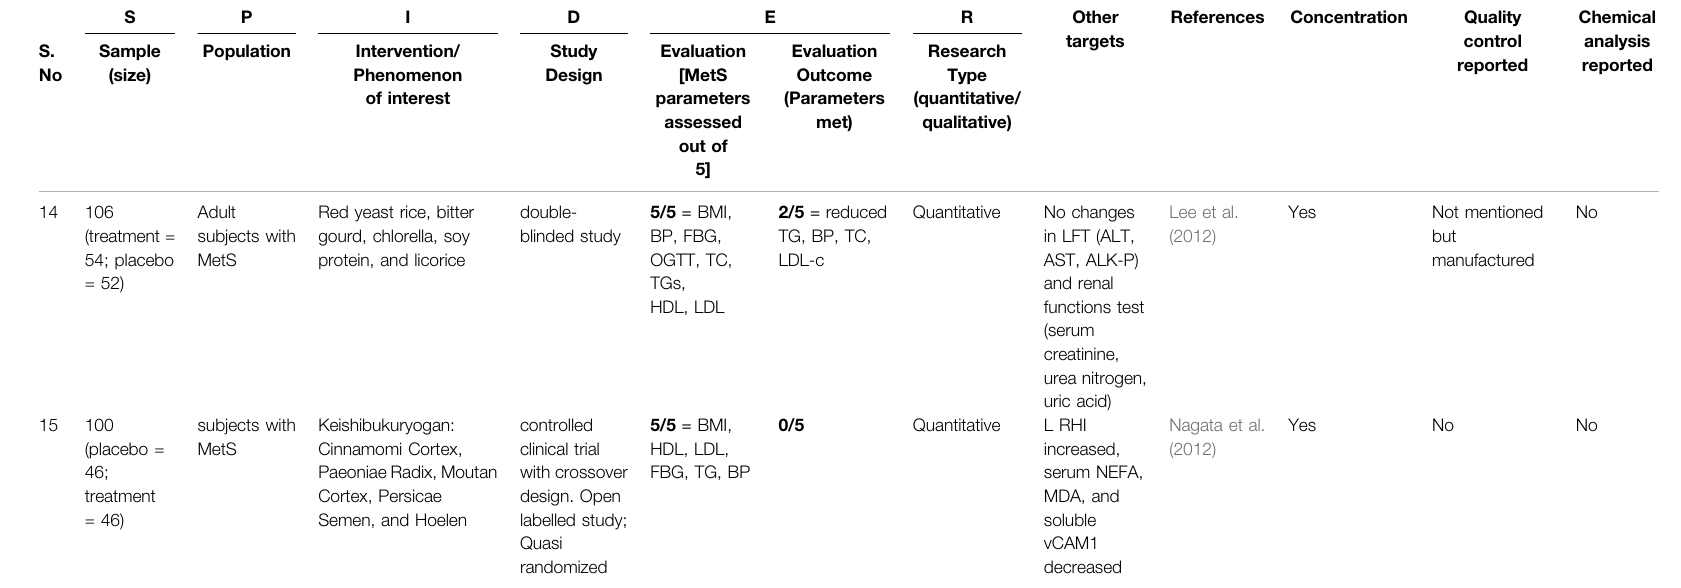
TABLE 5 | ( Continued ) Summary of meta-analysis of polyherbal combinations used in Clinical studies in patients with MetS according to SPIDER model, concentration, quality control and chemical classi fi cations